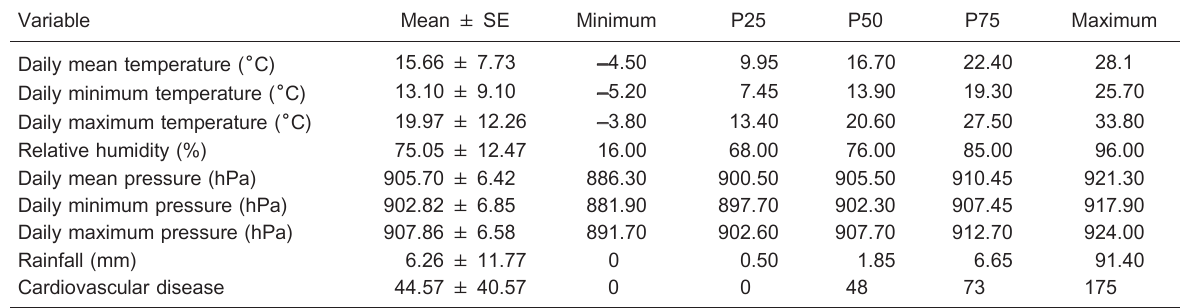
Table 1. Frequency distribution of daily air temperature, relative humidity, atmospheric pressure, rainfall and cardiovascular disease hospital outpatient admission from January 1, 2007 to November 11, 2009 in Zunyi, China.